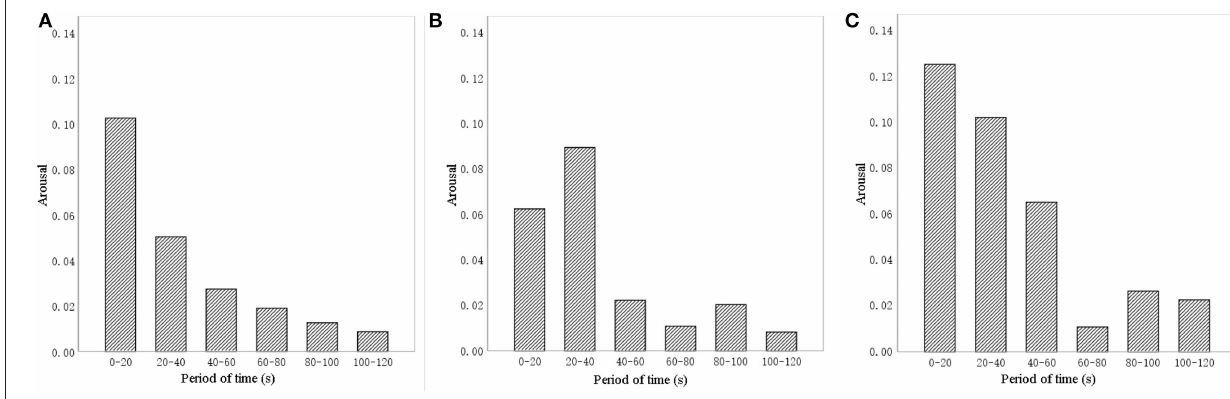
network: the AAM is used to compute scores of the probability and intensity of six facial expressions (happiness, surprise, fear, sadness, anger, and disgust) on a continuous scale from 0 (absent) to 1 (fully present) (Lewinski et al., 2014). FaceReader also calculates the valence and arousal of facial